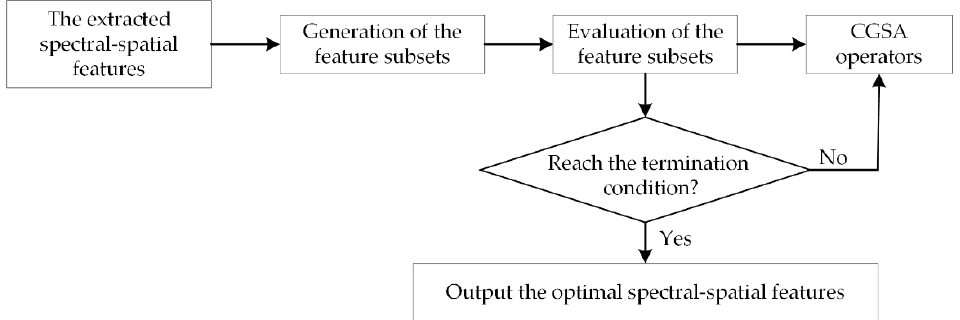
Figure 2. The crossover-based search algorithm-based feature selection.